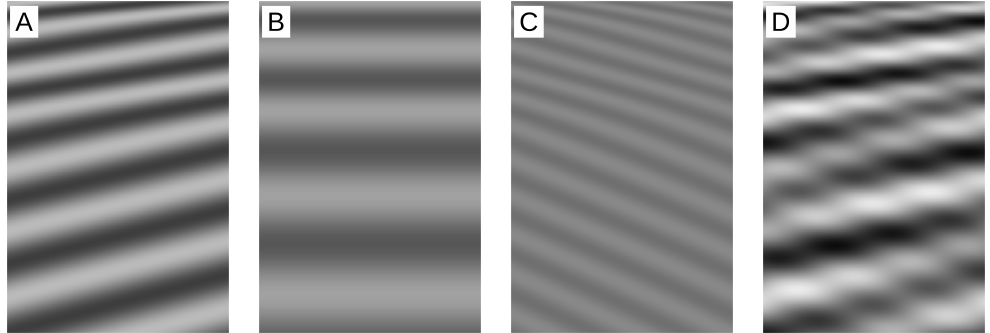
Figure 6. Initial snapshots for linear synthetic wave trains W1 ( A ), W2 ( B ), and W3 ( C ) and their superposition WS ( D ): Spatial domain is 200 m × 300 m (in the alongshore and cross-shore directions), and pixel intensity is a linear function of the modelled free surface